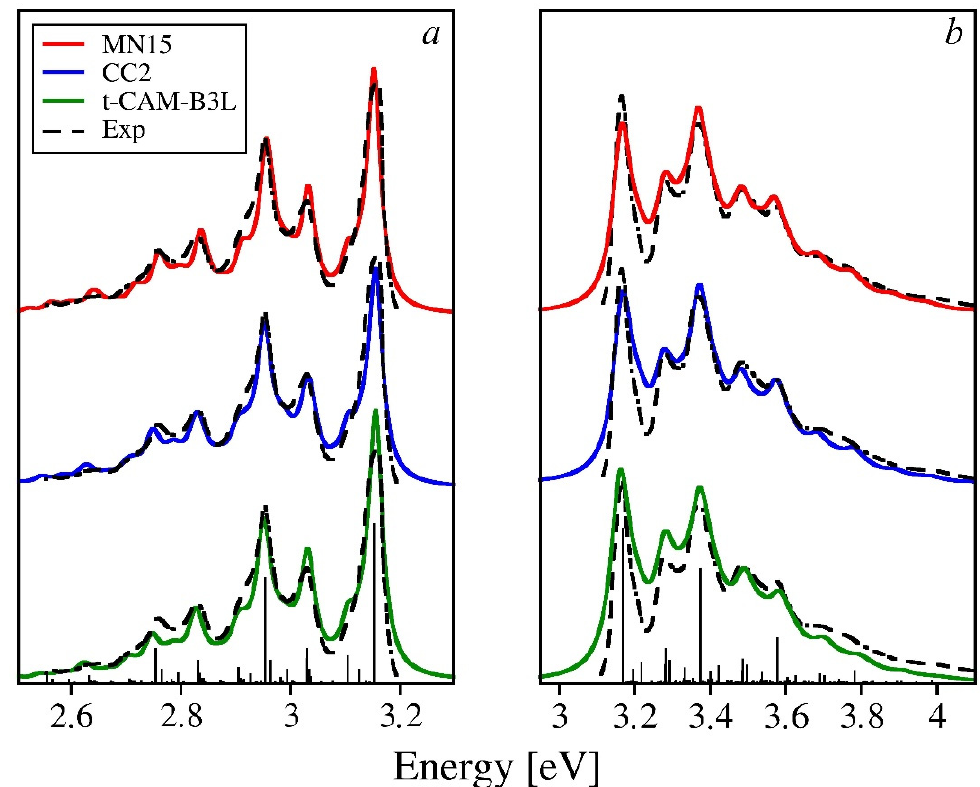
Figure 8. Emission ( a ) and absorption ( b ) spectra of 4O calculated using three theoretical methods selected in the previous section vs. the experimental spectrum by Seixas de Melo et al. [28]. The integral intensities of the theoretical spectra have been normalized to match the experiment. To ease the comparisons, the onsets of the computed spectra have been aligned to the experimental one. The stick spectrum has been obtained using the MN15 functional.